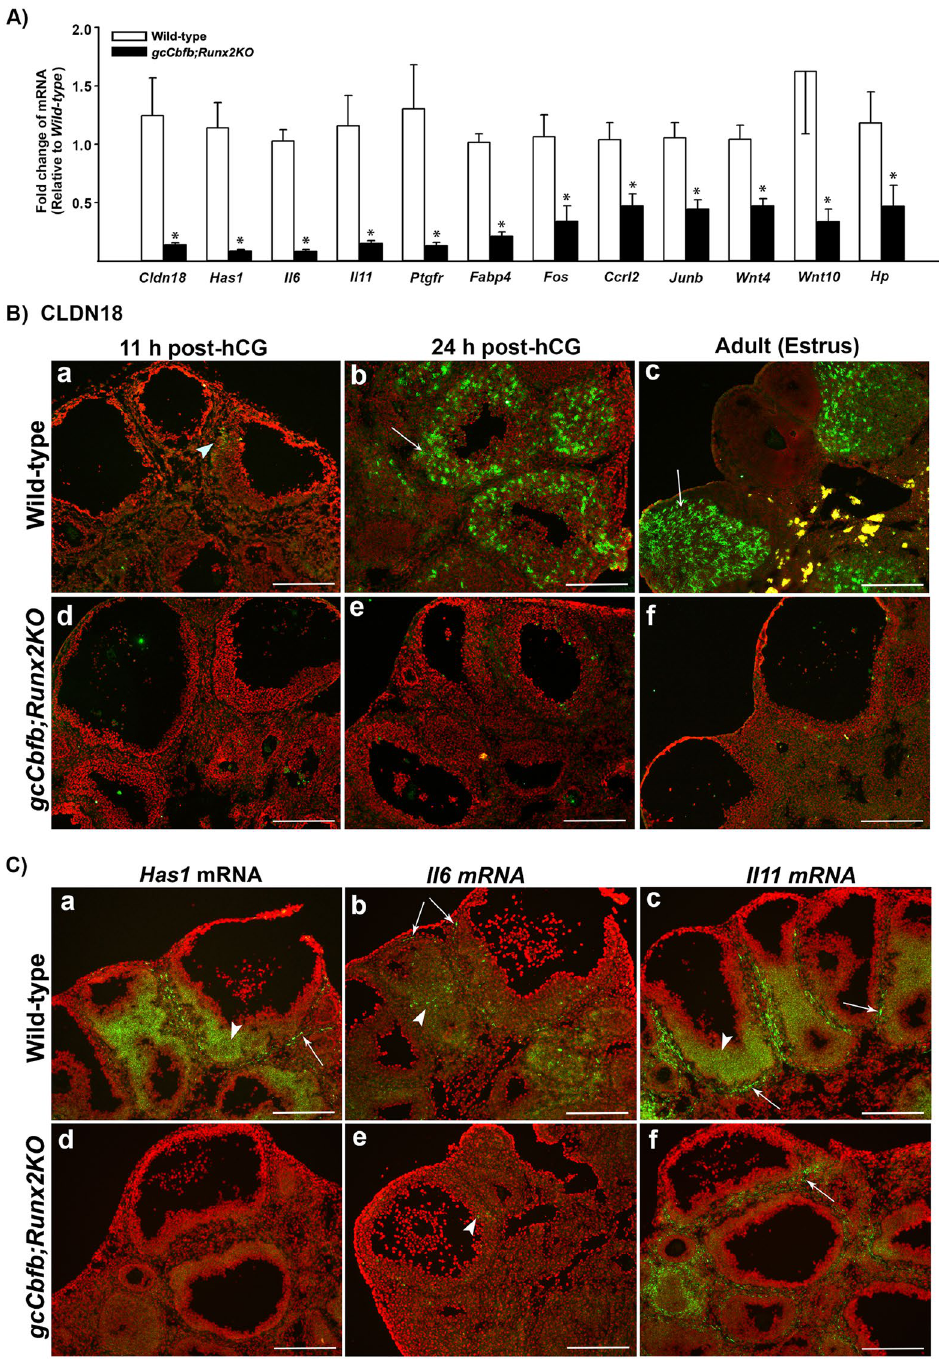
Figure 4. Identification of down-regulated genes in ovaries of gcCbfb;Runx2KO mice (I). ( A ) Ovaries were collected at 11 h after hCG administration from wild-type and gcCbfb;Runx2KO mice. A list of the most highly downregulated genes was selected from RNA-seq data analyses. The levels of mRNA for genes were measured by qPCR, normalizing to the Rpl19 value in each sample (n = 8 and 7 for control and mutant mice, respectively). * p < 0.01. ( B ) Ovaries were collected at 11 and 24 h after hCG administration from immature animals as well as in the morning of estrus from adult mice. The localization of CLDN18 was evaluated via immunohistochemical analyses (n = 3/genotype). CLDN18 was detected as green fluorescent staining, and the tissue sections were counterstained with propidium iodide (red). Arrowheads and arrows point to a few granulosa cells and luteal cells stained positively for CLDN18, respectively. ( C ) in situ hybridization analyses were used to localize mRNA for Has1 , IL6 , and IL11 in ovaries collected at 11 h post-hCG (n = 3/genotype). Transcripts for these genes were detected as green fluorescence signals. The tissue sections were counterstained with propidium iodide (red). Arrowheads and arrows point to granulosa cells of preovulatory follicles and cells in the theca layer positive for these gene transcripts, respectively. Scale bars, 250 μ m for all the